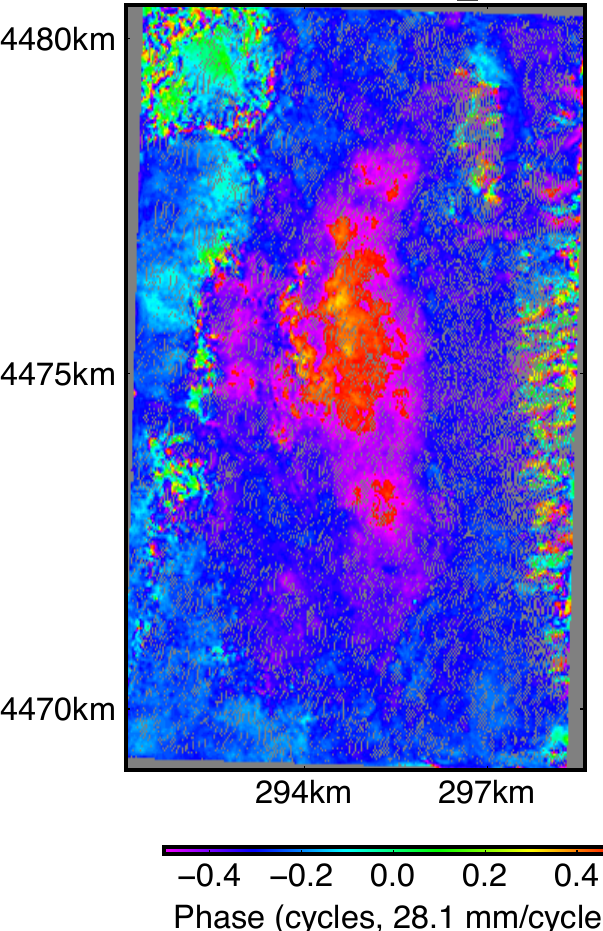
Figure A4. Deformation field at San Emidio in terms of wrapped range change in cycles from an Envisat track 120 pair spanning 15th February 2006 to 31st May 2006. One cycle of wrapped phase corresponds to a range change of approximately 28 mm. Orbital baseline b ⊥ = 232.1 m and temporal baseline ∆ t = 105 days. Coordinates are easting and northing kilometers in UTM projection zone 11N, WGS84